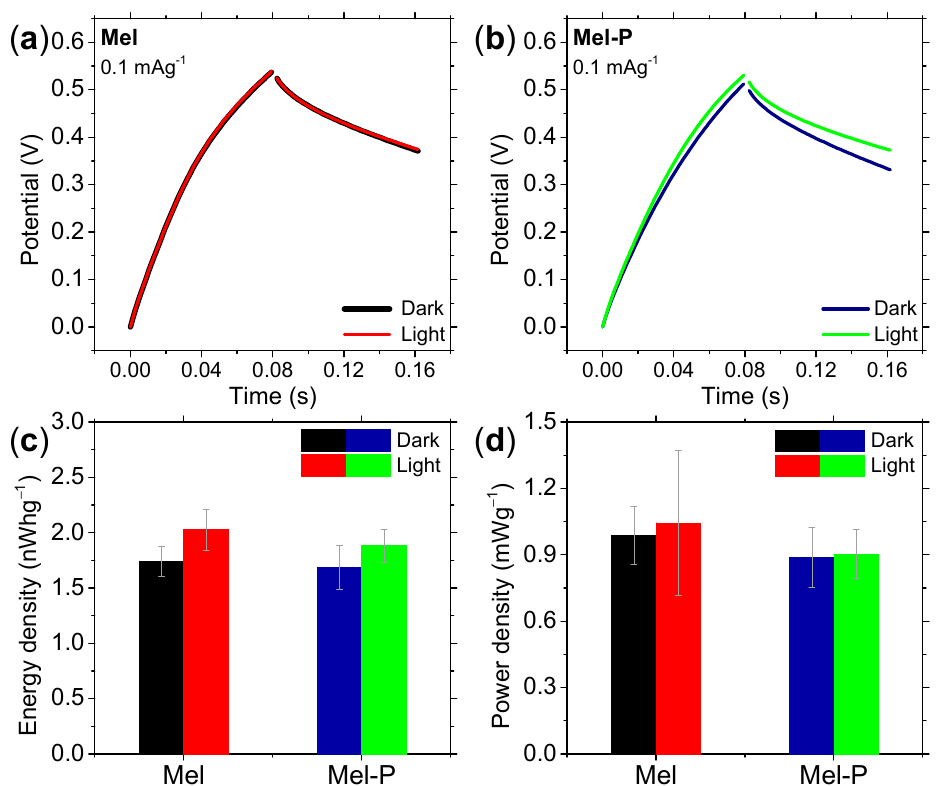
Figure 4. Galvanostatic charge and discharge curves of ( a ) Mel and ( b ) Mel-P supercapacitor in the dark and under illumination of 0.1 mAg − 1 . In ( a ), under both dark and light conditions, the curves showed the same overall behavior. ( c ) Energy density and ( d ) power density estimated for the supercapacitors under study.